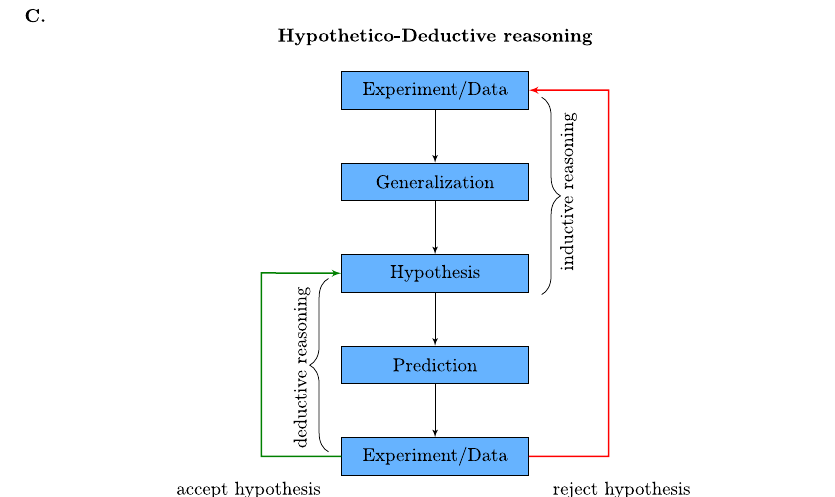
Fig. 1 Overview of three different inference approaches and hypothetico-deductive reasoning. A , B The three base forms of inference: inductive inference, deductive inference, and abductive inference. C Basic components and working mechanism of the hypothetico-deductive (HD)